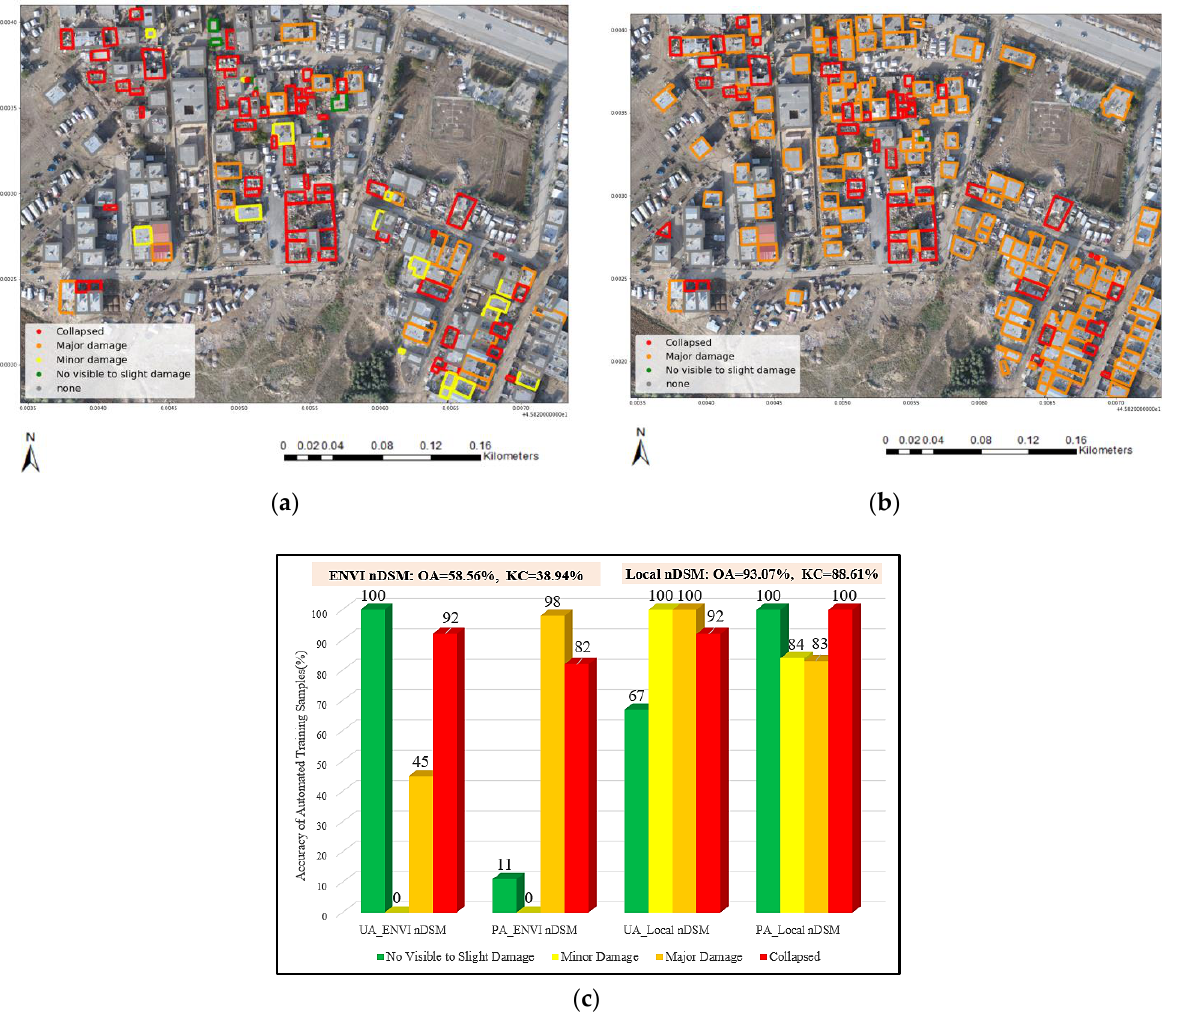
Figure 6. Automated selection of training samples: ( a ) detected training samples with applying novel local nDSM, ( b ) selected training samples with applying ENVI LiDAR nDSM, ( c ) accuracy assessment.